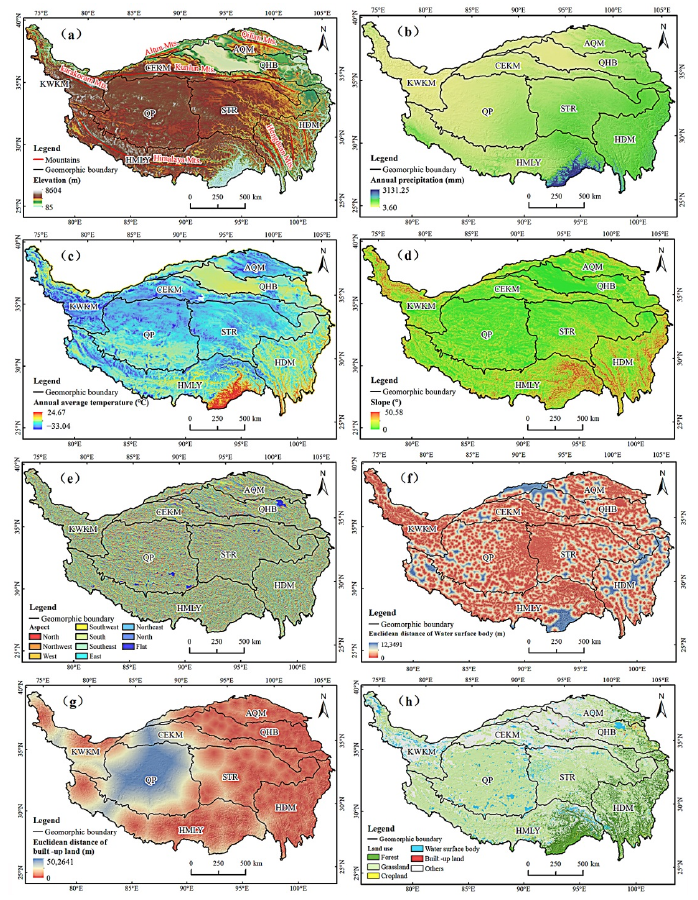
Figure 2. Maps of the eight factors. ( a ) Elevation; ( b ) Annual precipitation; ( c ) Annual average temperature; ( d ) Slope; ( e ) Aspect; ( f ) Euclidean distance of water surface body; ( g ) Euclidean distance of built-up land; ( h ) Land use and Land cover.